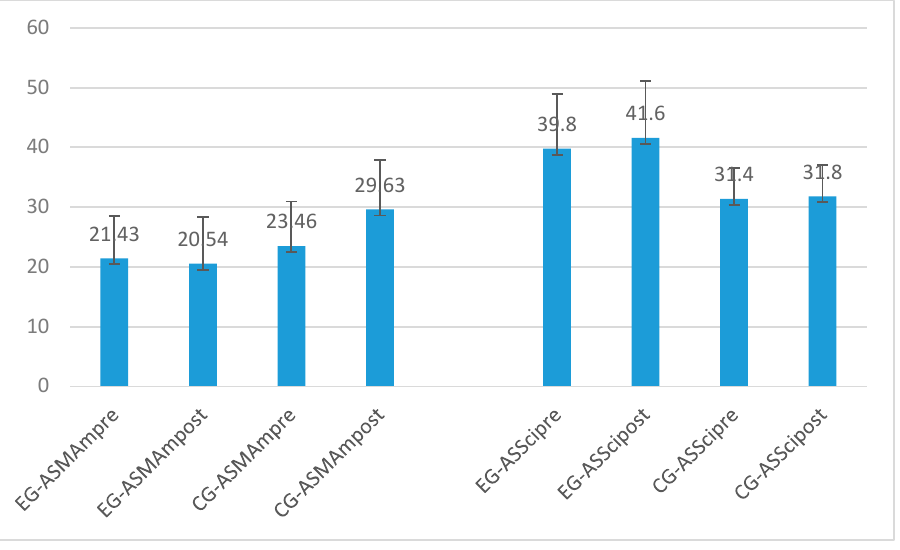
Figure 2. The attitude towards mathematics, ASMAm in the pre- and post-tests as well as the attitude towards school science, ASSci in pre- and post-tests are depicted for the experimental (EG), and control group (CG). N EG = 274; N CG = 179. ( p = 0.005 for ASMAmpre and ASScipre in EG and CG).